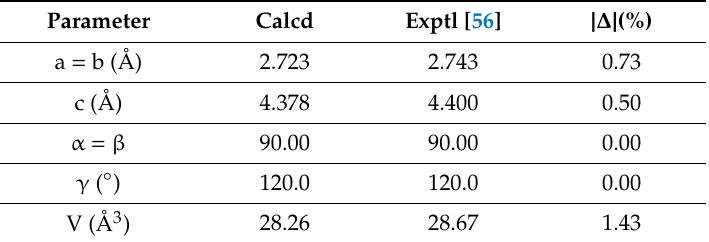
Table 1. Comparison between the experimental and calculated structural parameters of hexagonal ( P 63/ mmc )